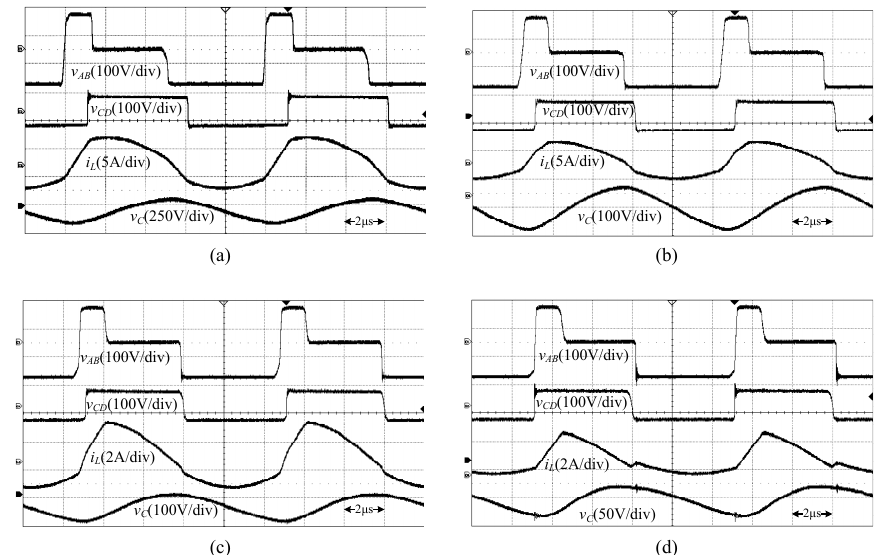
Figure 15. Experimental waveforms of different power levels when M = 0.6: ( a ) P o = 200 W, ( b ) P o = 150 W, ( c ) P o = 100 W, ( d ) P o = 50 W.